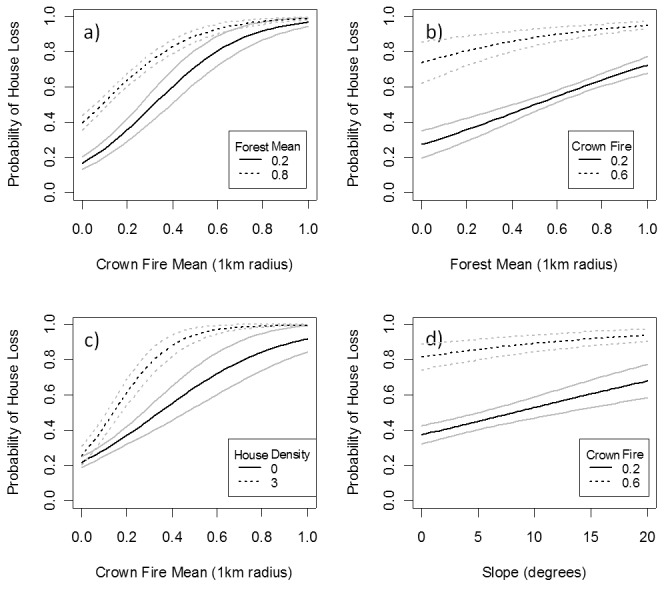
The modeled relationship between likelihood of house loss and predictor variables crown fire, forest area, house density and slope.95% confidence intervals are shown as grey lines. Predicted effects on house loss of: a) crown fire at quartile levels of forest extent; b) Forest area at quartile levels of crown fire; c) crown fire at two levels of house density; d) Slope at quartile levels of crown fires. For each plot, the unplotted variables are held at their median values.